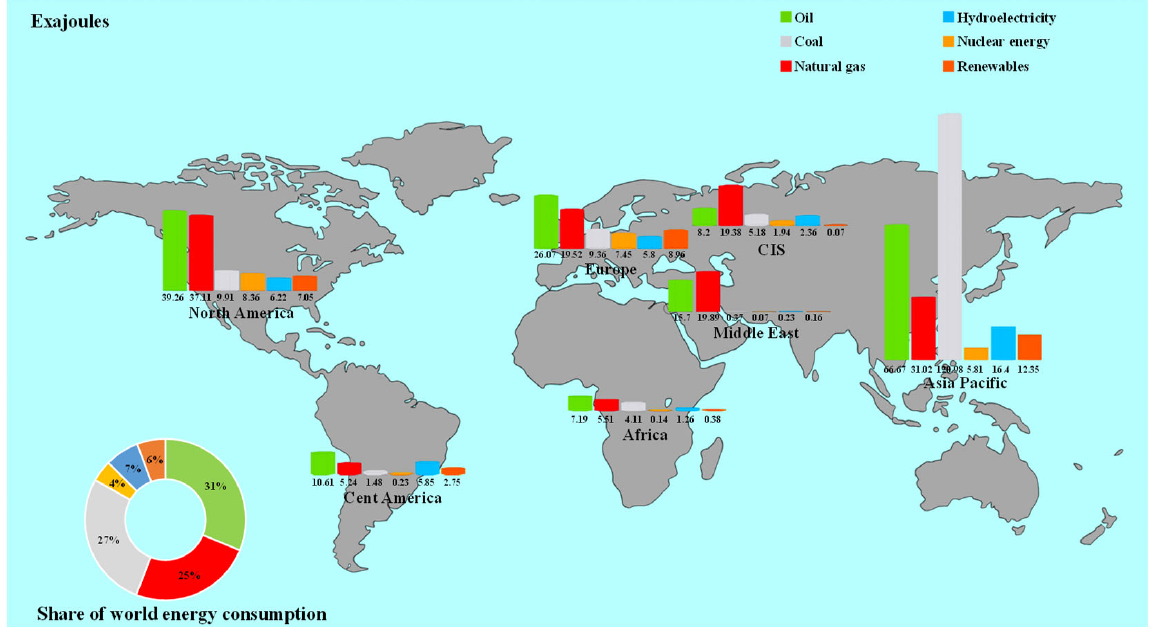
Figure 1. Percentage of energy consumption by continents and regions in the world in 2020.